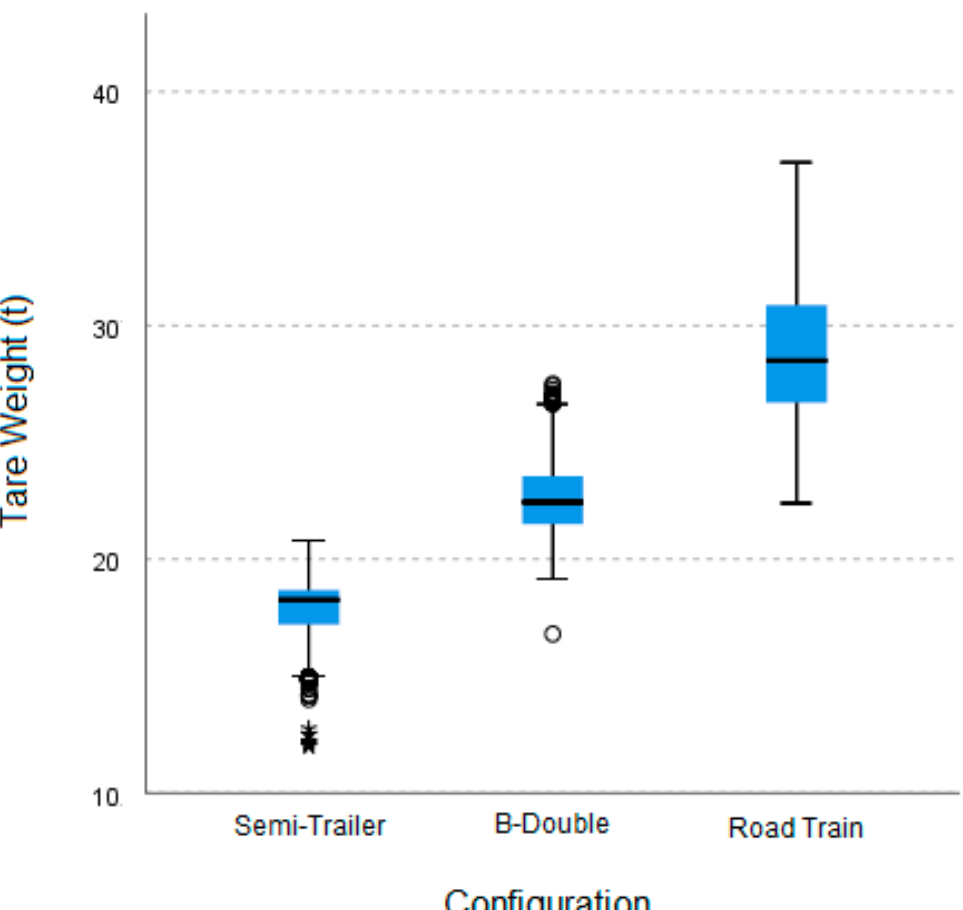
Figure 2. Tare weight statistical characteristics box plot of independent samples Kruskal–Wallis Test. Table 7. Net payload pairwise comparison of configurations for being the same